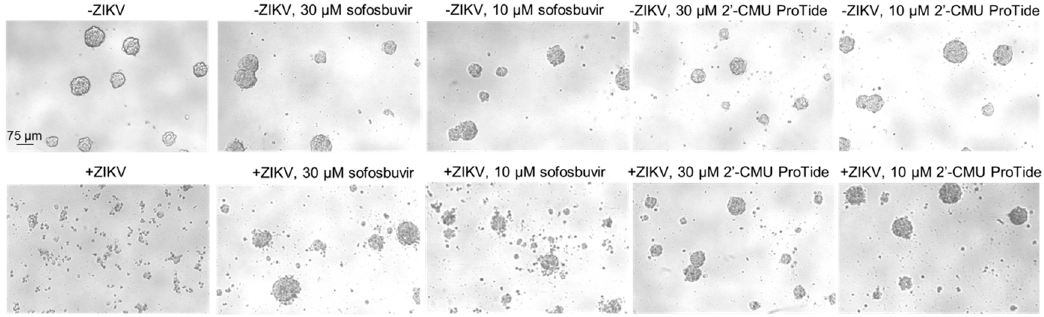
Figure 2. Protection from ZIKV-induced cytopathic effect by 2’- C -methyluridine aryloxyl phosphoramidate ProTide and sofosbuvir in a ZIKV-sensitive glioblastoma stem cell model. DMSO-treated GSC 387 cells [-ZIKV and +ZIKV, H/PAN multiplicity of infection (MOI) 10], 10 or 30 μ M sofosbuvir-treated cells or 10 or 30 μ M 2’-C-methyluridine aryloxyl phosphoramidate ProTide (2’-CMU ProTide)-treated cells were incubated for 72 h at 37°C and 5% CO 2 , and cell foci were subsequently imaged in bright-field.